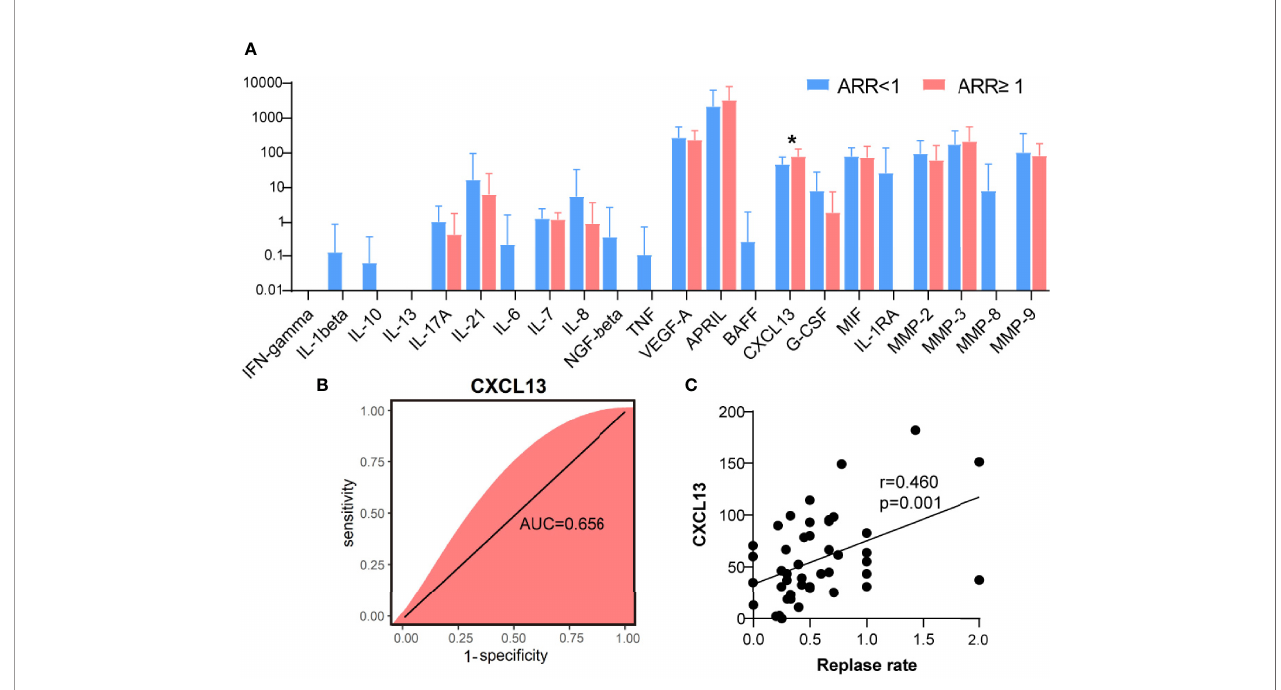
FIGURE 1 | C-X-C motif ligand 13 (CXCL13) as a biological marker for neuromyelitis optica spectrum disorder recurrence. (A) Quanti fi cation of in fl ammatory cytokines between two groups of patients with NMOSD (N = 37 in ARR<1 patients, N = 9 in ARR ≥ 1 patients). (B) Random forest analysis showed the CXCL13 could discriminate the two groups based on the area under the curve (0.656). (C) Using the CXCL13, a relatively poor correlation was achieved with Spearman ’ s correlation analysis ( r = 0.460). ARR, annual recurrence rate. *p <